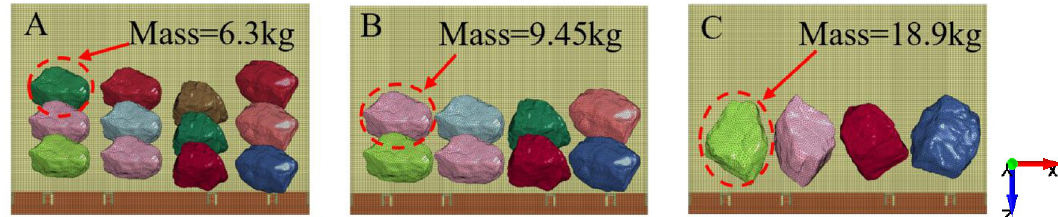
Fig 18. Different rock sizes. (A) The mass of single particle is 6.3kg. (B) The mass of single particle is 9.45kg. (C) The mass of single particle is